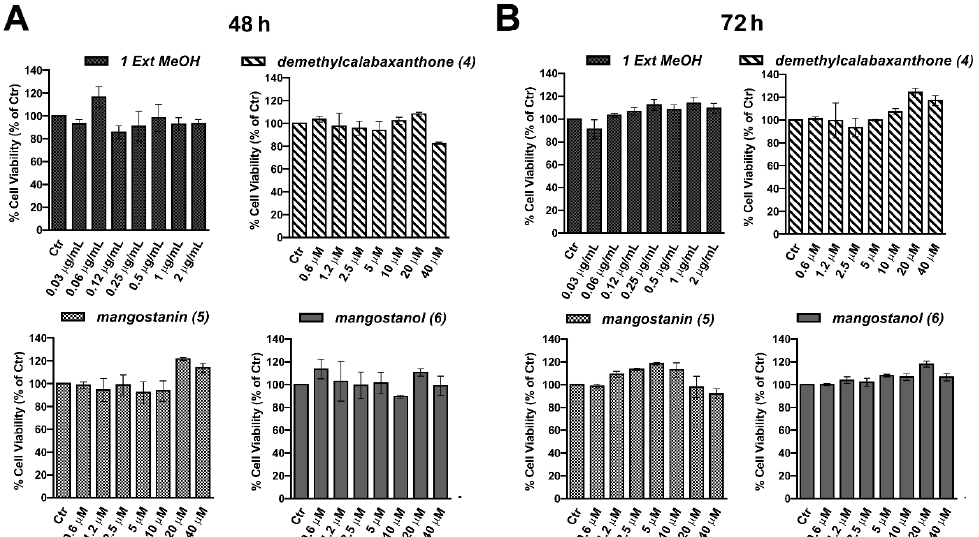
Figure 3. Evaluation of the methanol extract of G. mangostana arils and compounds 4 – 6 effects in HaCaT cells. Human keratinocytes were grown for 48 h ( A ) or 72 h ( B ) with individual compounds (0 – 40 µM) or extract (0 – 2 µg/mL) before MTT assay. Independent experiments were performed in triplicate, and the results are expressed as means ± SD and reported as % vs. the untreated cell (Ctr) (ANOVA).